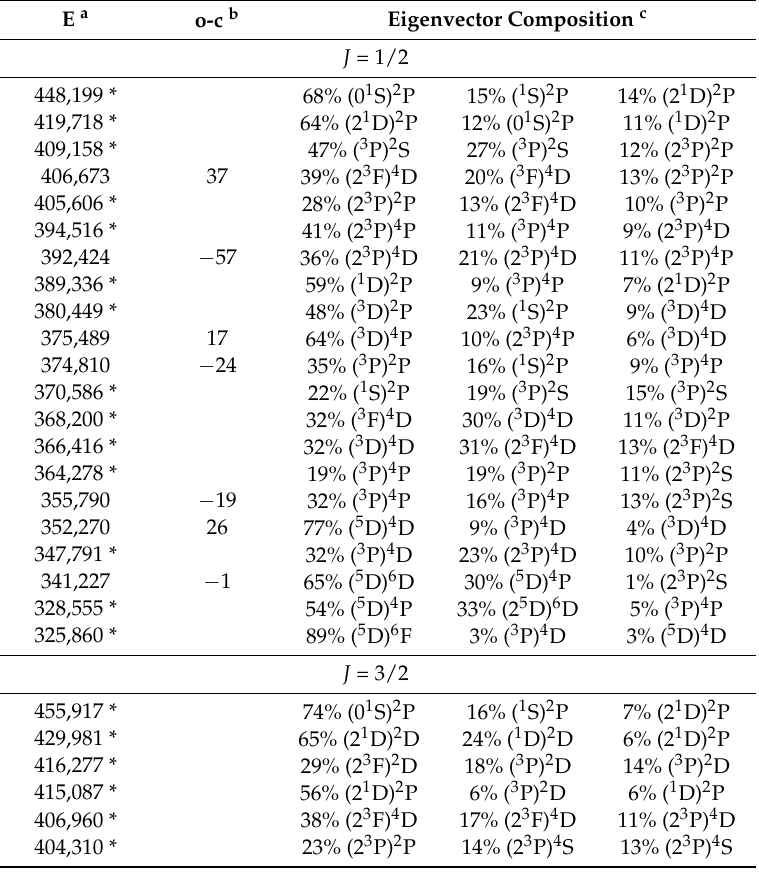
Table A6. Energies (in cm − 1 ) of the 4d 4 5p configuration of Ag